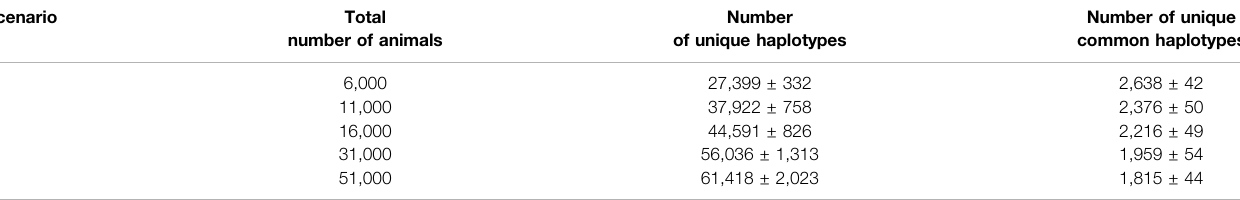
TABLE 1 | Simulation scenarios.